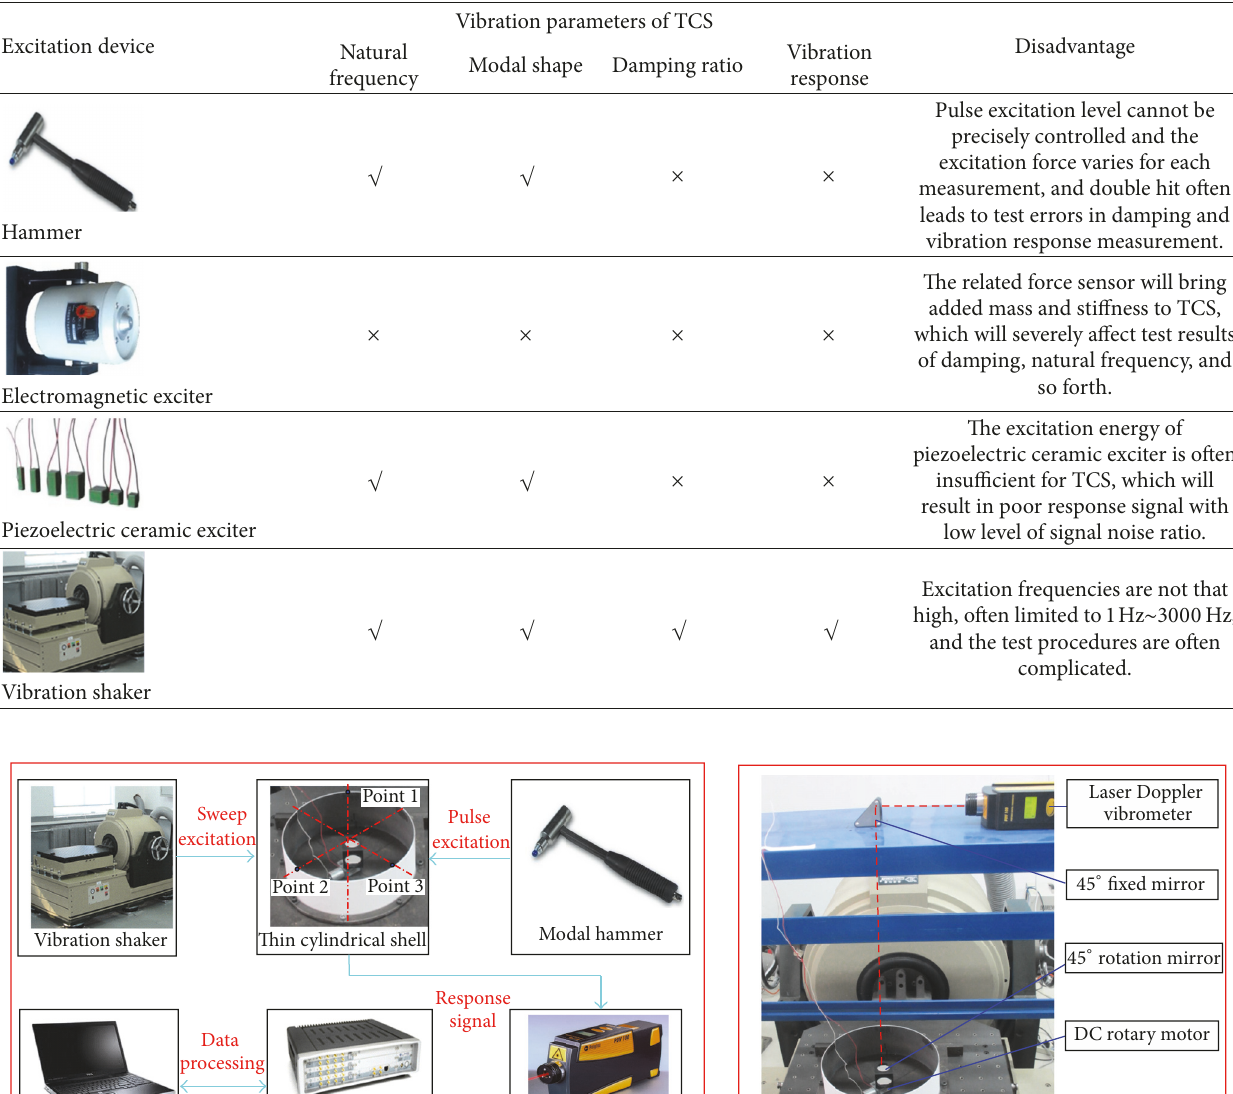
Table 4: The disadvantages of different vibration excitation devices for vibration test of TCS with or without hard coating.